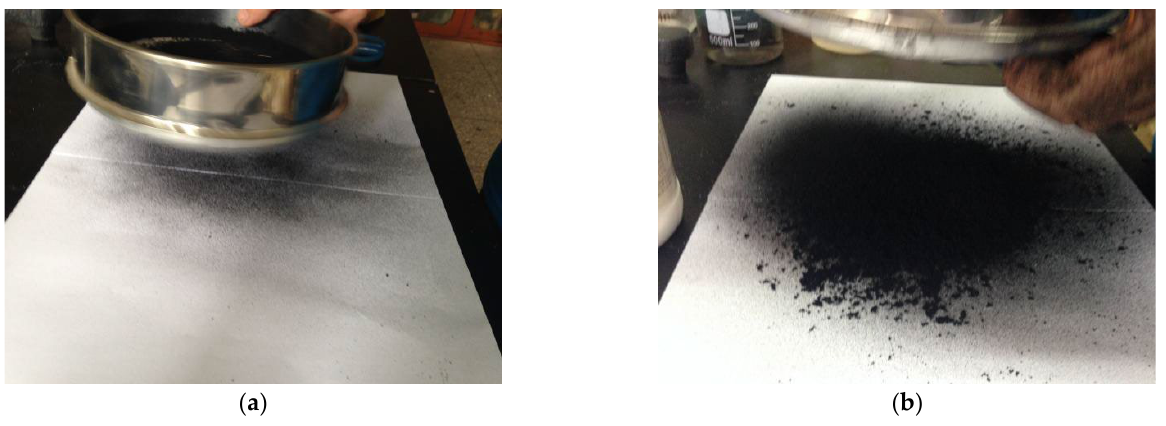
Figure 2. Particle screening. ( a ) Primary screening particles, ( b ) Particle after